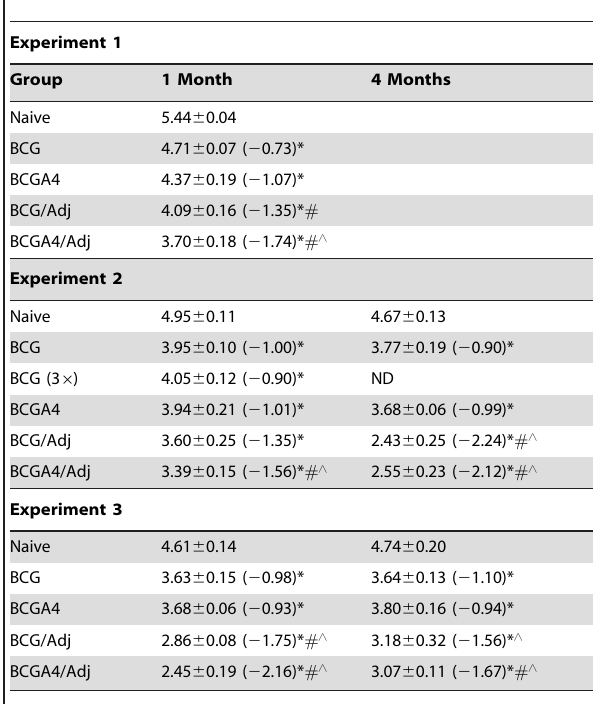
Table 1. Evaluation of the anti-tuberculosis protective immunity induced by BCG strains formulated in DDA/TDB adjuvant at one month and four months